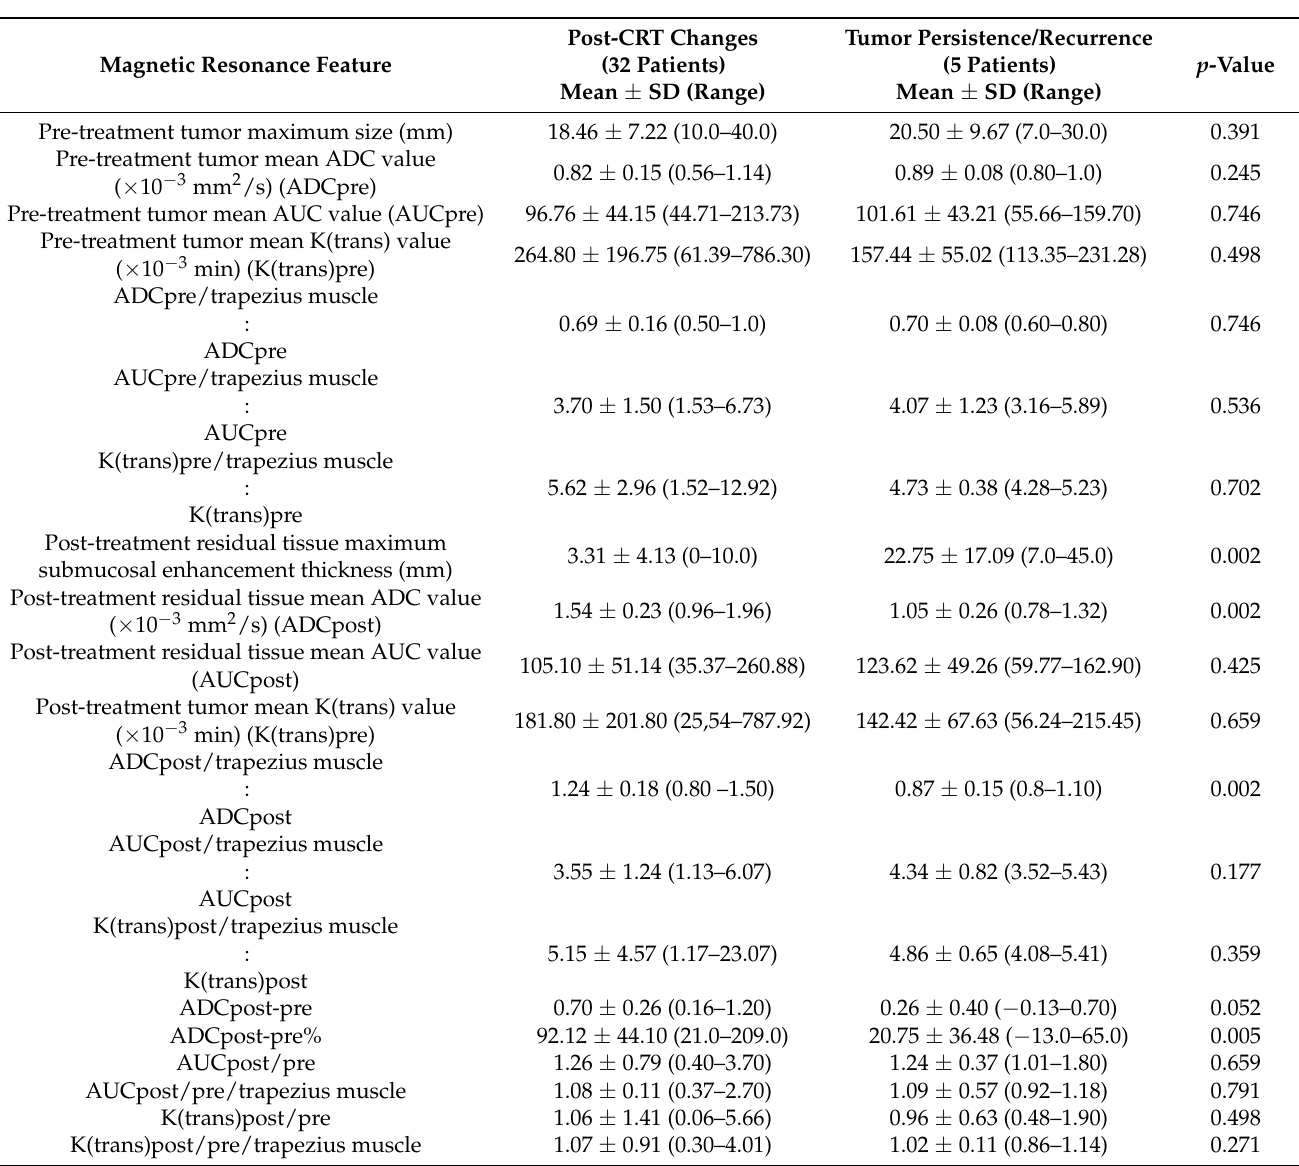
Table 1. Mean, standard deviation, and range values of the post-chemoradiotherapy tissue changes and tumor persistence/recurrence. CRT: chemoradiotherapy. ADC: apparent diffusion coefficient. AUC: area under the curve. K(trans): the volume transfer constant from the vascular space to the extravascular extracellular space. p -value: probability